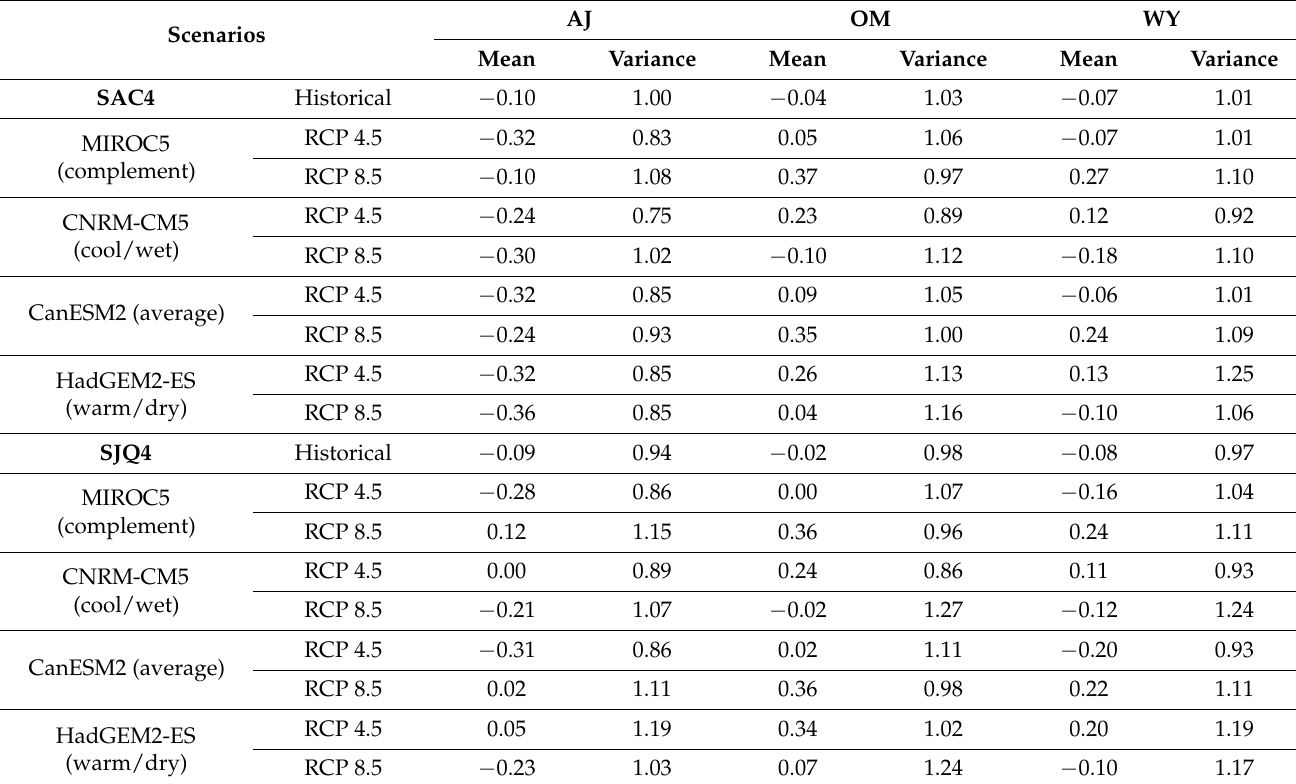
Table A2. Mean and variance of seasonal and annual SSI indices.